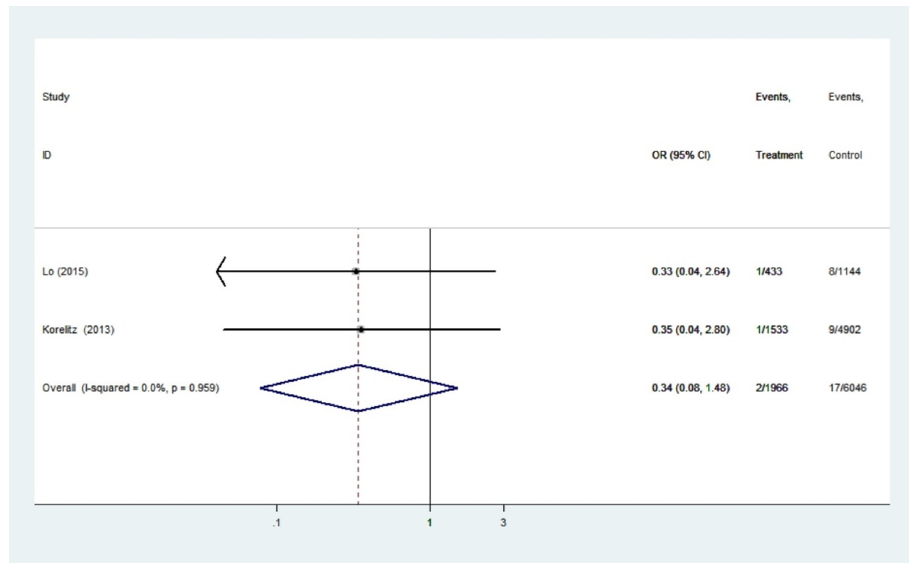
Fig 6. Forest plots of showing the effects of PTU on hepatotoxicity.